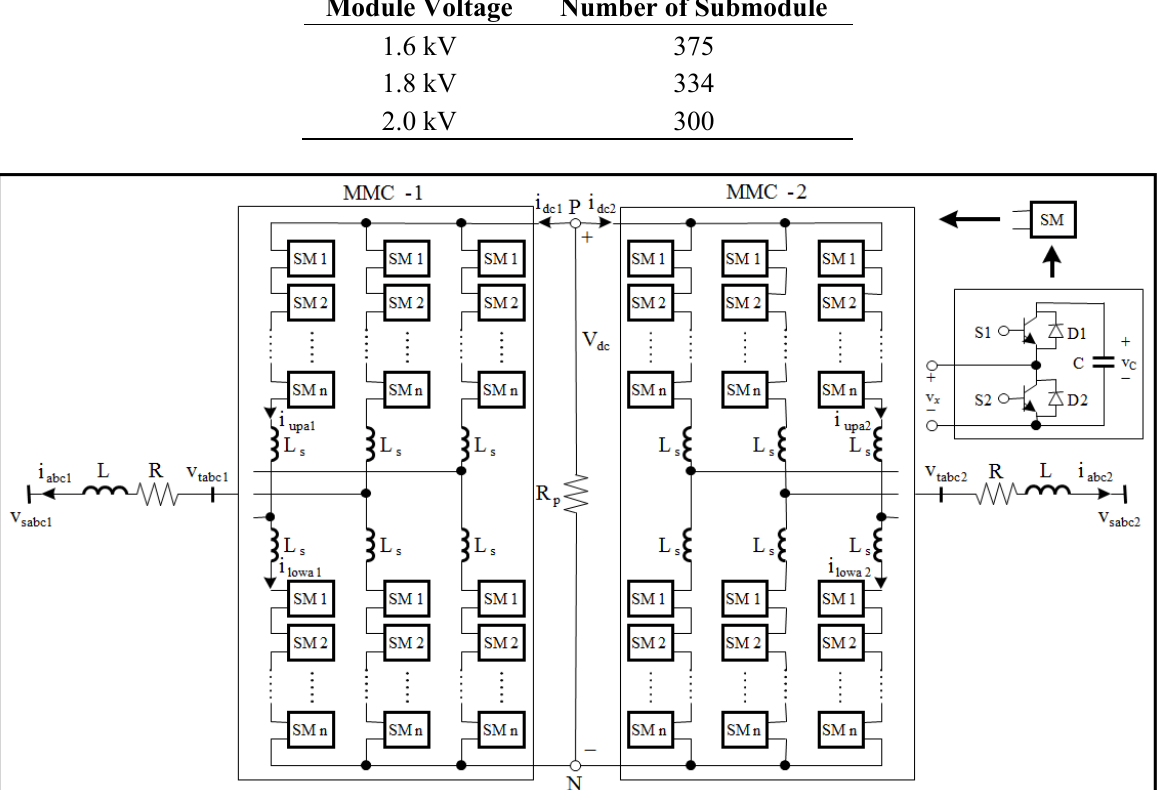
Figure 2. Modular Multilevel Converter